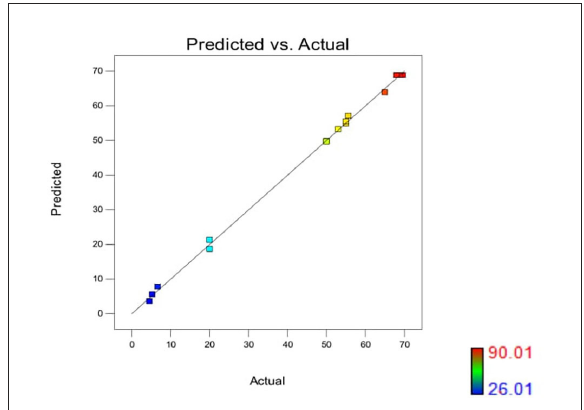
FIGURE7 Color points by value of %SU in Pseudomonas monteillii (actual vs. predicted). Upon experimentation, actual values for maximum bacterial growth were falling in line with the predicted values, i.e., pH = below 9, Fe = 9–15 µ M, NH 4 NO 3 15 g/l, whereas for siderophore production, actual values were also somehow similar to predicted values, · pH = below 7, Fe = 7–13 µ M , NH 4 NO 3 15 g/1, and 89.9% siderophore units was